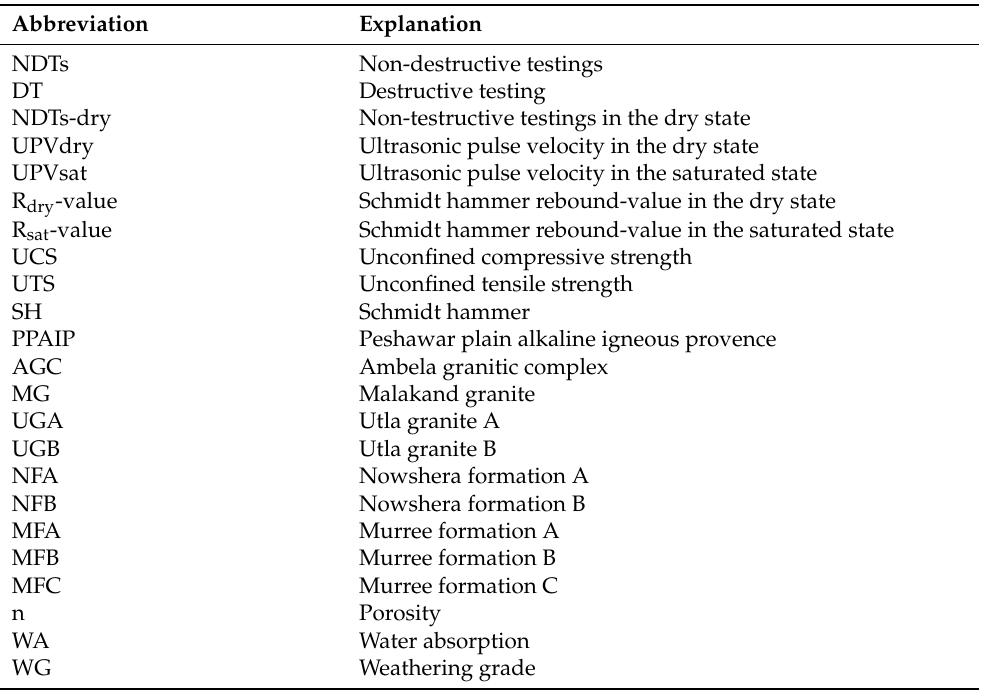
Table 1. List of abbreviations and acronyms used in this